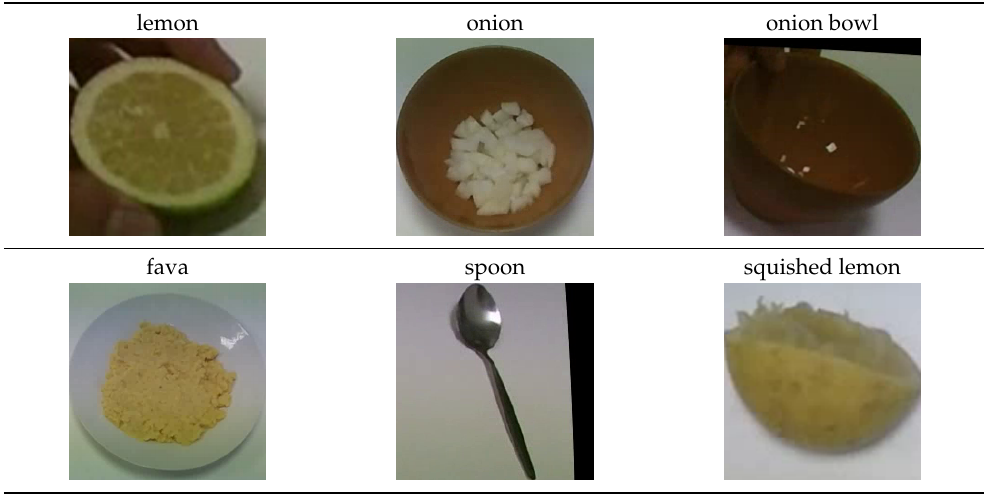
Table 3. Indicative images from the dataset for “Fava” recipe. For the ingredients and utensils that are not shown (oil, salt, plastic bowl, plastic cup) please refer to Table